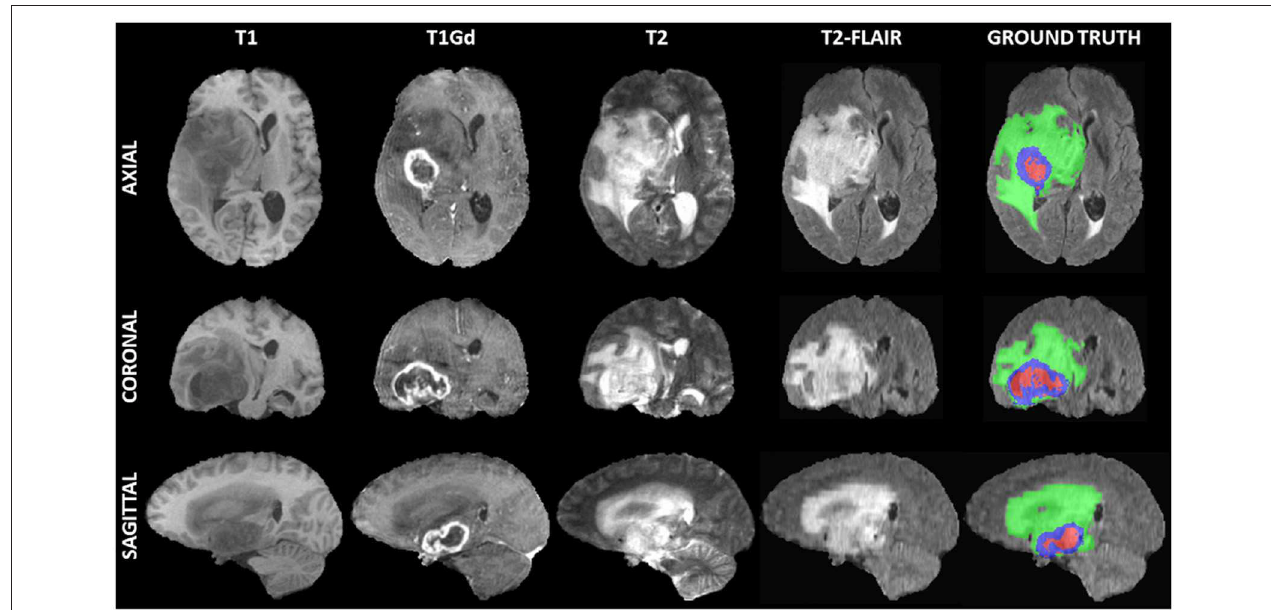
FIGURE 1 | Example of a 3D input multi-parametric Magnetic Resonance Imaging scan from the International Brain Tumor Segmentation (BraTS) challenge. From left to right all four input modalities are illustrated, including native T1-weighted (T1), T1 post-contrast (T1Gd), native T2-weighted (T2), and T2 Fluid Attenuated Inversion Recovery (T2-FLAIR), followed by the ground truth expert annotation of all three tumor sub-regions, provided as part of the BraTS dataset. From top to bottom three views (i.e., Axial, Coronal, Sagittal) of these 3D volumes are depicted to showcase the 3-dimensional nature of these scans.